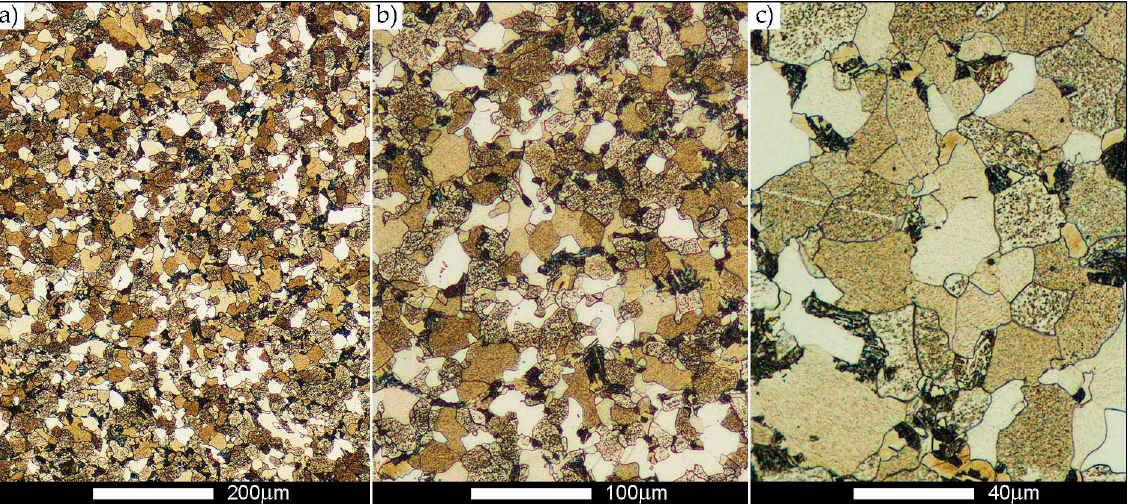
Figure 36. Welded joint microstructure of Hardox 450 in the delivery state (directly after welding) with revealed grain boundaries of prior austenite—WM2 zone shown in Figure 2. ( a ) 100×; ( b ) 200×; ( c ) 500×.